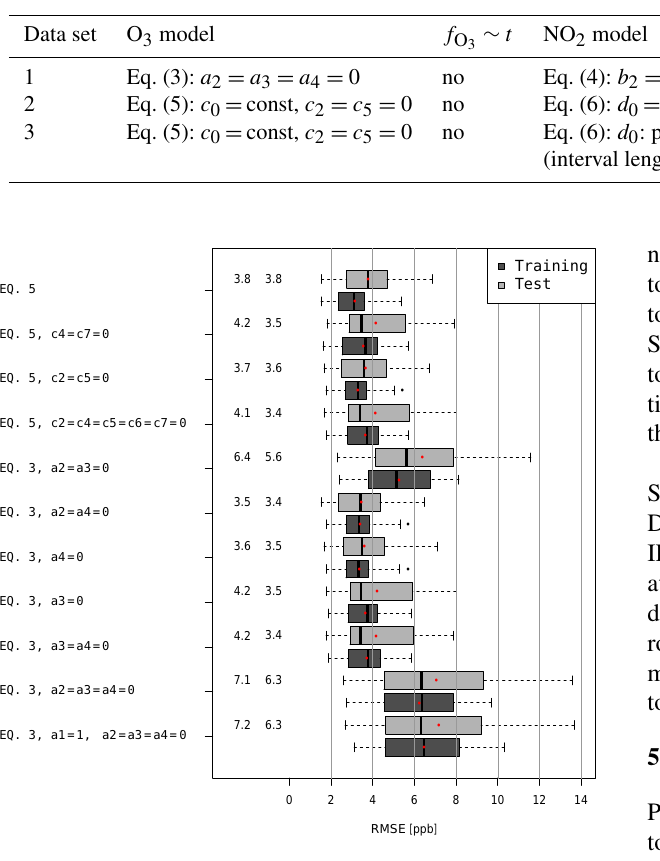
Table 4. Description of the computed data sets. f O REM denote whether the parameters of the sensor model are determined based on data from co-location periods or also from data during sensor network operation.